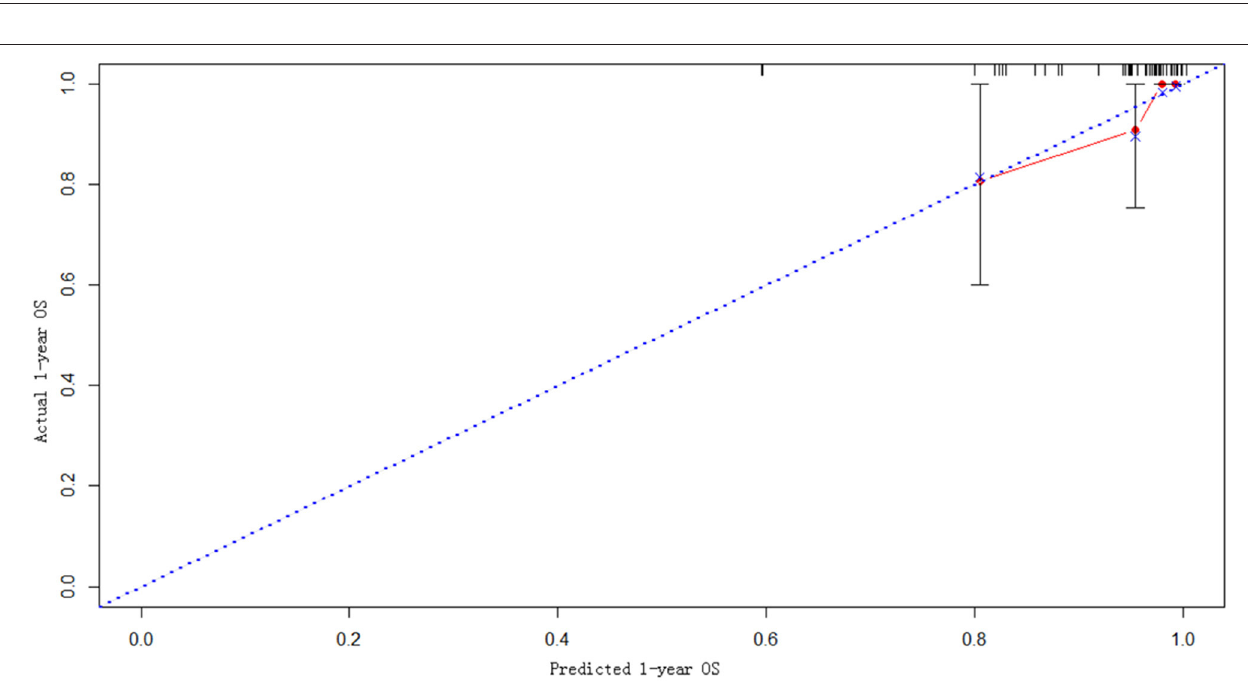
FIGURE 5 | Nomogram predicting 1- and 3-year overall survival of colon cancer patients.